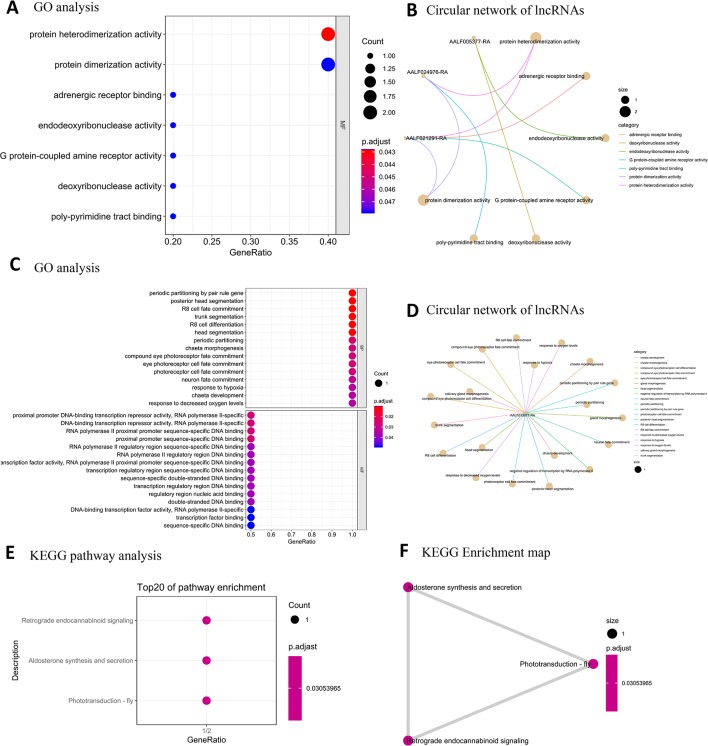
GO and KEGG pathway enrichment analysis of male/female high-expression lncRNA target protein-coding genes. (A) Top GO terms for MF for male high-expression lncRNA target protein-coding genes. (B) Circular network of male high-expression lncRNA target protein-coding genes and BCs. (C) Top GO terms for female high-expression lncRNA target protein-coding genes. (D) Circular network of female high-expression lncRNA target protein-coding genes and BCs (E) Top KEGG pathway terms for female high-expression lncRNA expression. (F) Enrichment map organizing enriched terms into a network with edges weighted by the ratio of overlapping gene sets.